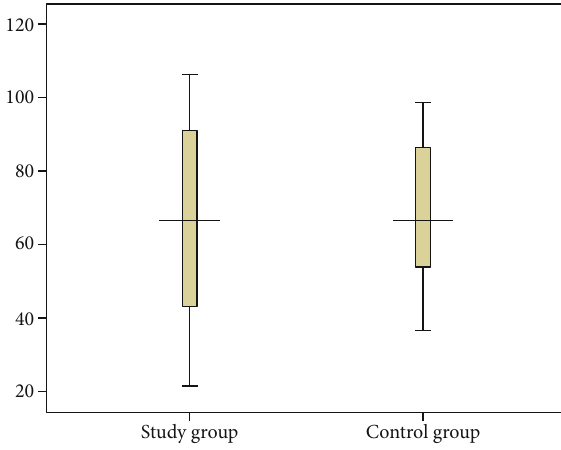
Figure 3: The box-plot distribution and comparative analysis survival time of patients without drainage treatment from study group ( n = 20 ) and control group ( n = 93 ) ( 65 : 0 ± 26 : 63 vs. 67 : 22 ± 22 : 16 ; [95% CI]: -9.012-13.442, t = 0 : 391 , P value =